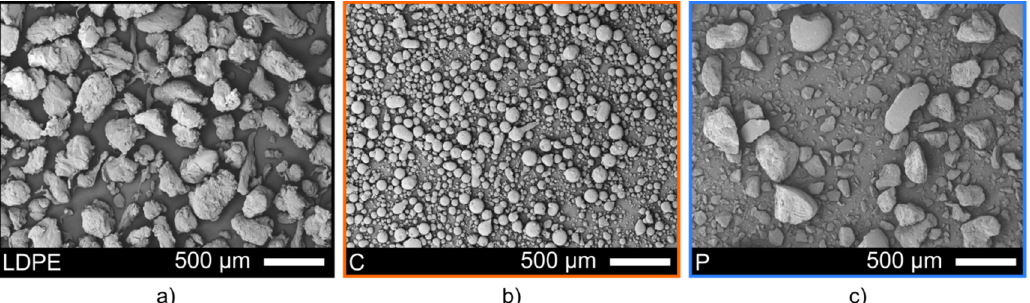
Figure 2. SEM micrographs of the as-received feedstock powders: ( a ) LDPE powder (LDPE), ( b ) fully hydrogenated cottonseed oil powder (C), and ( c ) hard paraffinic wax powder (P).